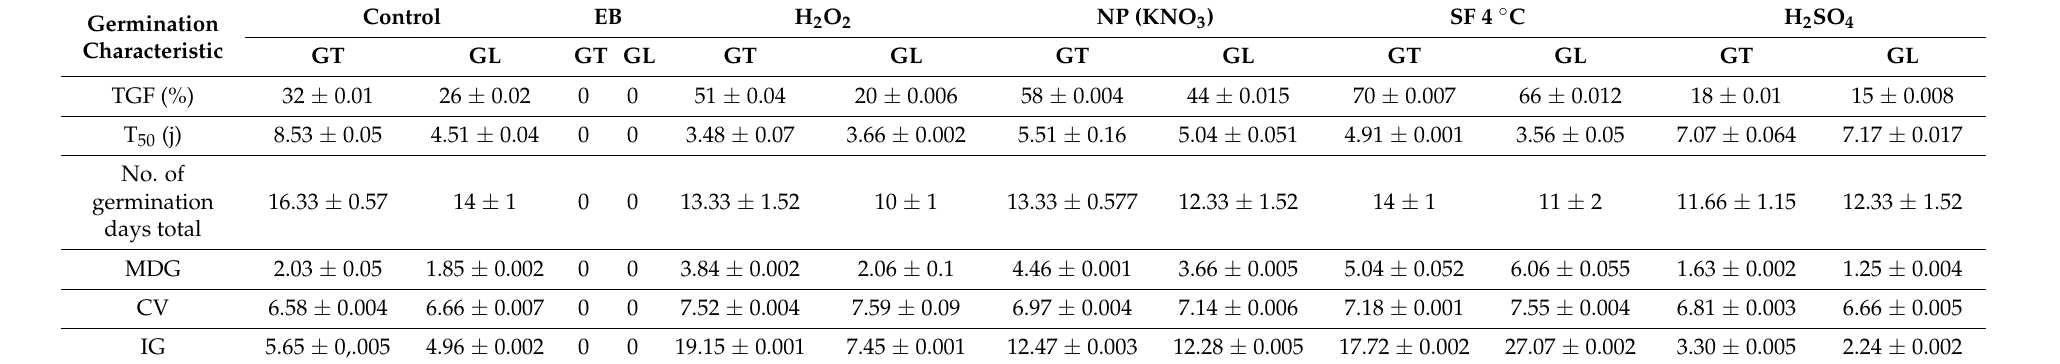
Table 5. Averages of the main germination parameters of A.P var. depressus seeds (GL: peripheral seeds; GT: central seeds) on filter paper, according to the different